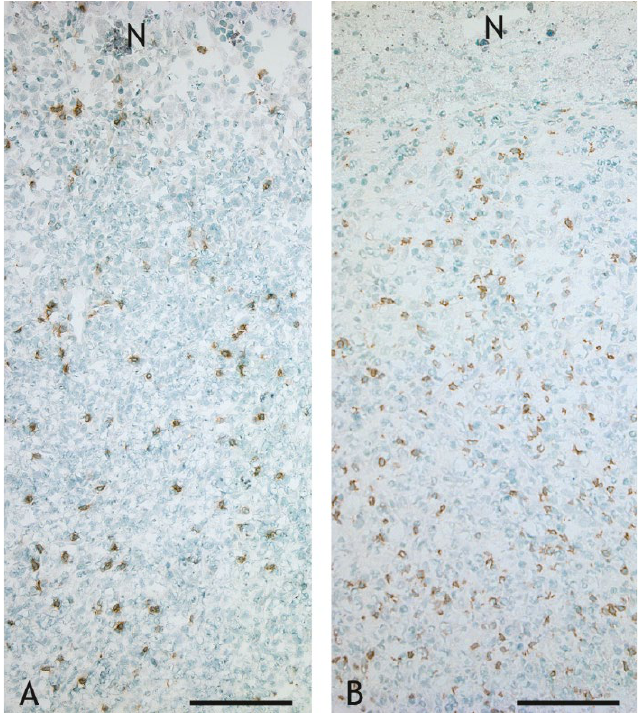
Figure 14. CD8 + T cells in the inflammatory infiltrate of granulomas. The number of CD8 + T cells is higher in the VPM1002-induced granuloma (( B ), goat 24) compared to the BCG-induced granuloma (( A ), goat 13). IHC, CD8. Scale bars =100 µm.